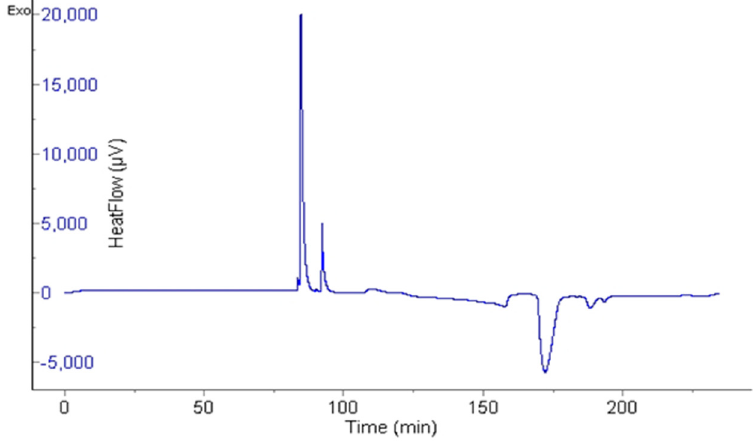
Figure 2. µ -DSC curve for hydrate formation and Figure 2. µ-DSC curve for hydrate formation and dissociation.